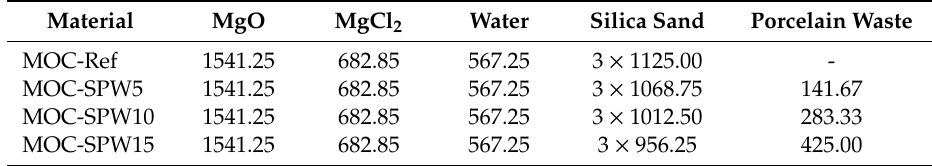
Table 1. Composition of magnesium oxychloride cement (MOC) composites